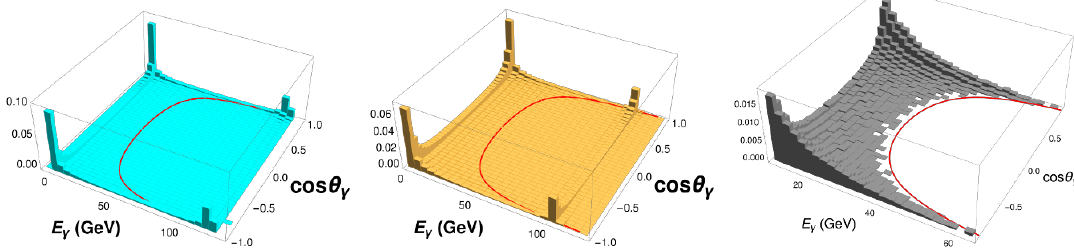
Figure 6 . Photon E (cid:13) (cid:0) cos (cid:18) (cid:13) distributions in millicharged models e + e (cid:0) ! (cid:31) (cid:22) (cid:31)(cid:13) (left) with m (cid:31) = 1 GeV and " = 0 : 01, in SM irreducible BG e + e (cid:0) ! (cid:23) (cid:22) (cid:23)(cid:13) (center), and in SM reducible BG p e + e (cid:0) ! e + e (cid:0) (cid:13) (right). s = 240 GeV is used here. The red curves on each plot indicate the p s (1 + sin (cid:18) (cid:13) = sin (cid:18) b ) (cid:0) 1 where cos (cid:18) b = 0 : 99. The E (cid:13) (cid:0) cos (cid:18) (cid:13) region kinematic relation E (cid:13) = E m = B on the right panel plot is E (cid:13) > 10 GeV & j cos (cid:18) (cid:13) j < 0 : 9, which is di(cid:11)erent from the (cid:12)rst two